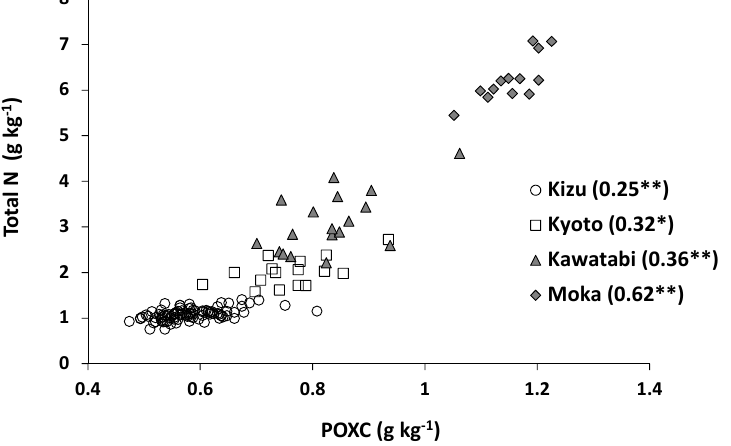
Figure 8. Relationship between POXC (potassium permanganate-oxidizable organic C) content and total N content at farm scale. ** and * indicate statistical significance of the determination coefficients at p < 0.01 and p < 0.05, respectively.